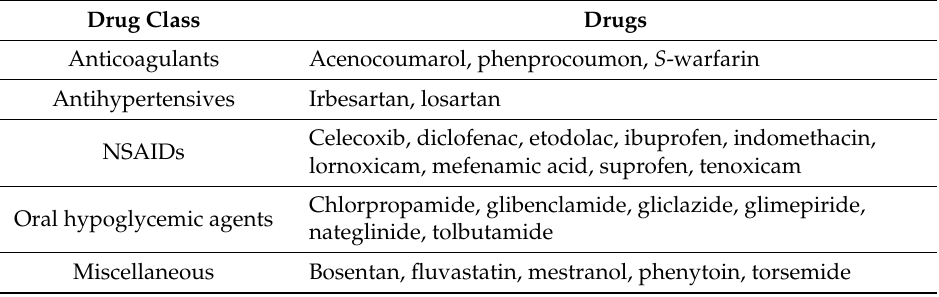
Table 1. Representative examples of drugs for which CYP2C9 is responsible for >25% of metabolic